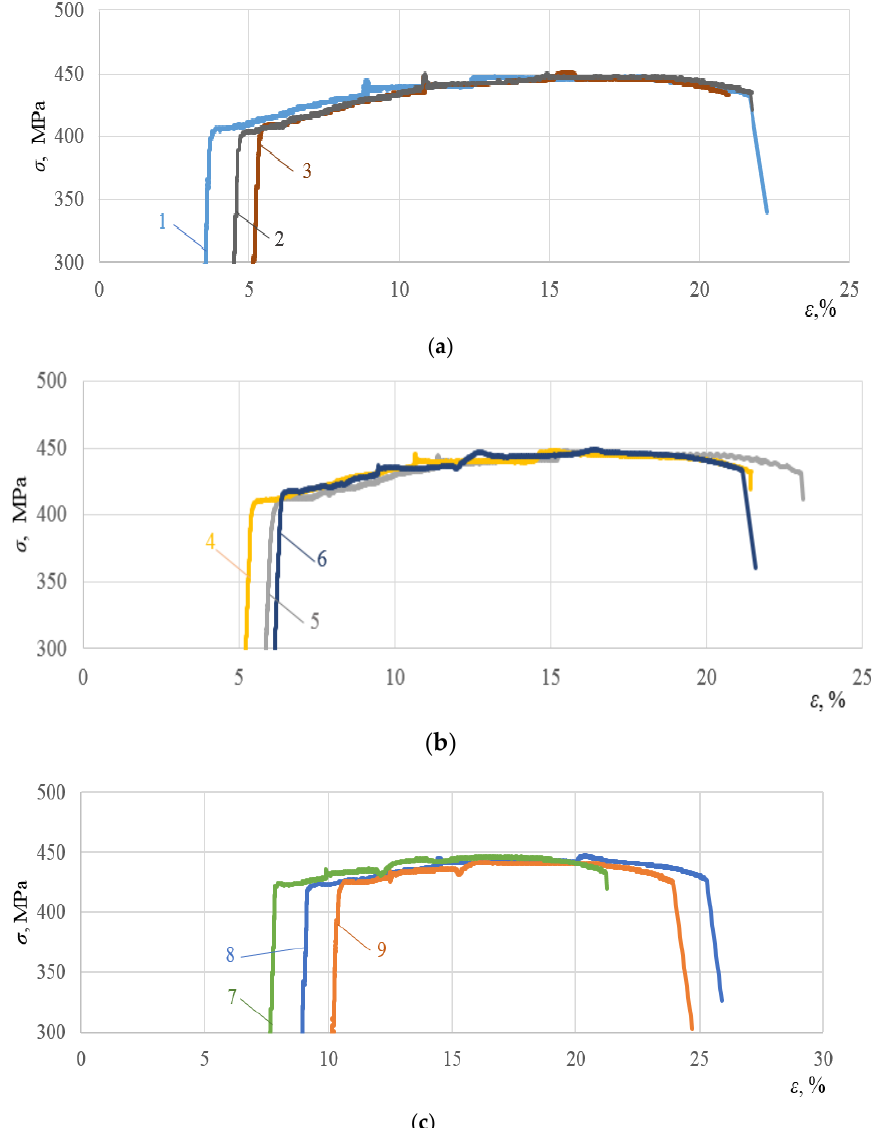
Figure 5. Deformation diagrams of the T alloy during static stretching after DNP of different intensities:: ( a ) — 1 —ε imp = 3.12%; 2 —ε imp = 4.06%; 3 —ε imp = 4.69%; ( b ) — 4 —ε imp = 4.75%; 5 —ε imp = 5.37%; 6 — ε imp = 5.75%; ( c ) — 7 —ε imp = 7.25%; 8 —ε imp = 8.44%; 9 —ε imp = 9.69%.